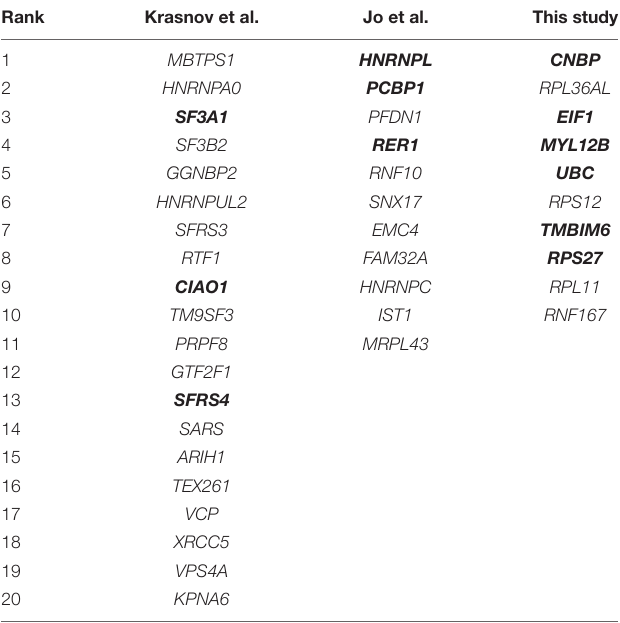
TABLE 1 | Candidate reference genes from different studies.